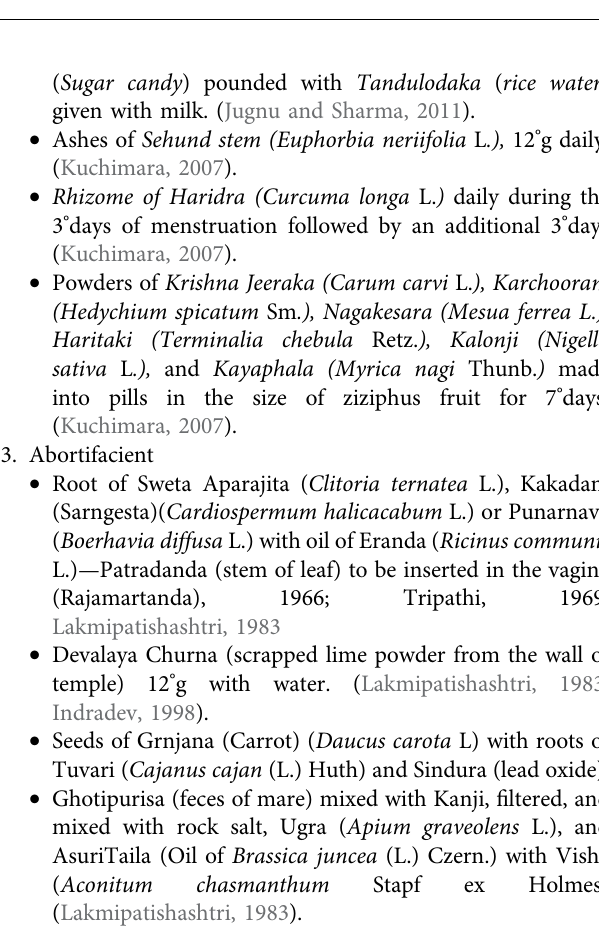
FIGURE 3 | Contraception in the context of Ayurvedic principle of